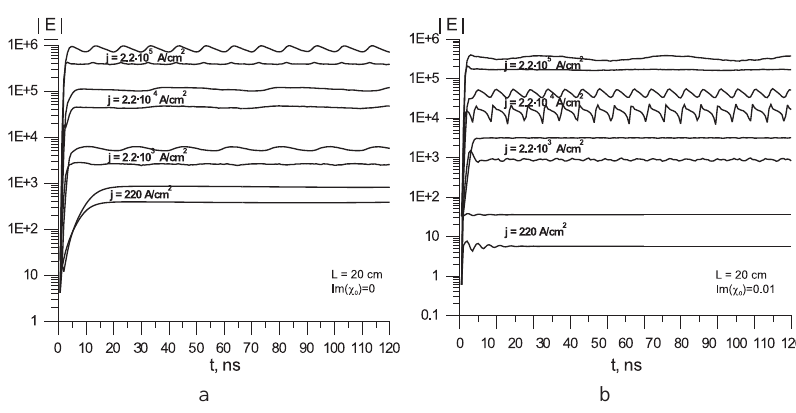
Figure 3. Numerical solution for different current density j without (a) and with (b) absorp- tion in Bragg